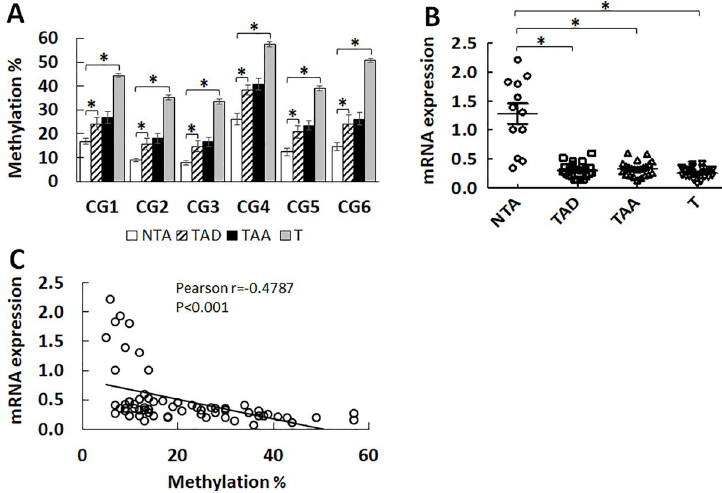
Fig 2. Methylation of PLA2G16 increases in tumor and normal prostate tissue from patients with PC. A: The DNA methylation of PLA2G16 in prostatectomy specimens was compared between NTA (non-tumor-associated, n = 12) patients without cancer, T (tumor, n = 26), TAA (tumor-associated adjacent, n = 26), and TAD (tumor- associated distant, n = 25). The tumors had the highest percent methylation. Significant differences in methylation between the NTA and T, TAA, and TAD were noted. The graph shows Mean ± SEM, one way Anova � p < 0.05 for TAD or T when compared to T. B: PLA2G16 gene expression was evaluated using RNA from the same samples. Significantly decreased expression (relative expression value X100) was observed in all T, TAA, and TAD than NTA. The values in both A and B are from 3 individual experiments, shown as Mean ± SEM, one way Anova, � p < 0.05. C: Correlation between PLA2G16 methylation and gene expression was analyzed using Pearson, the graph presents CG2 methylation vs expression (X100) in all NTA, T, TAA and TAD samples.